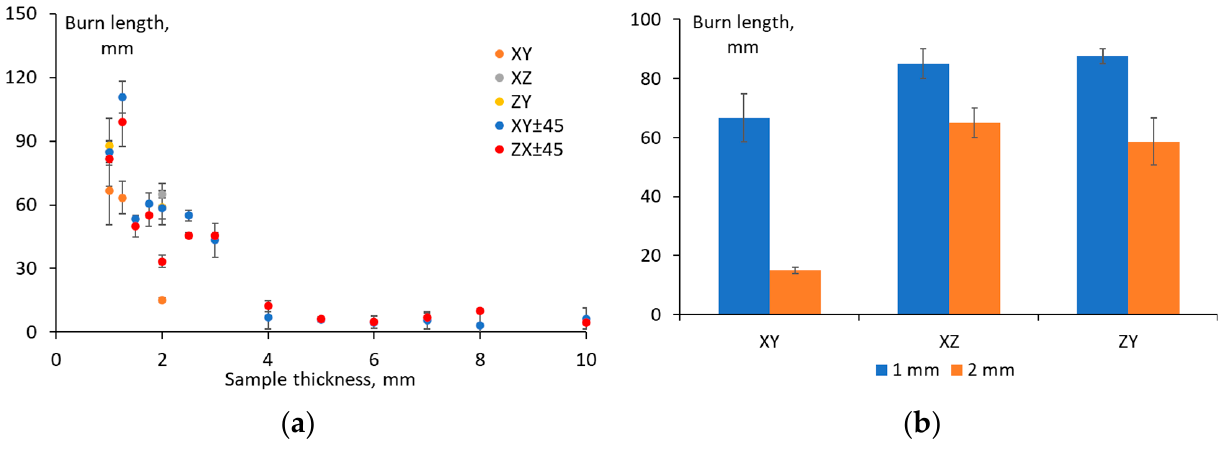
Figure 4. Burn length as a function of sample thickness for different printing directions, as indicated on graph ( a ), and burn length as a function of printing directions, as indicated on the graph for the samples of thickness 1 and 2 mm ( b